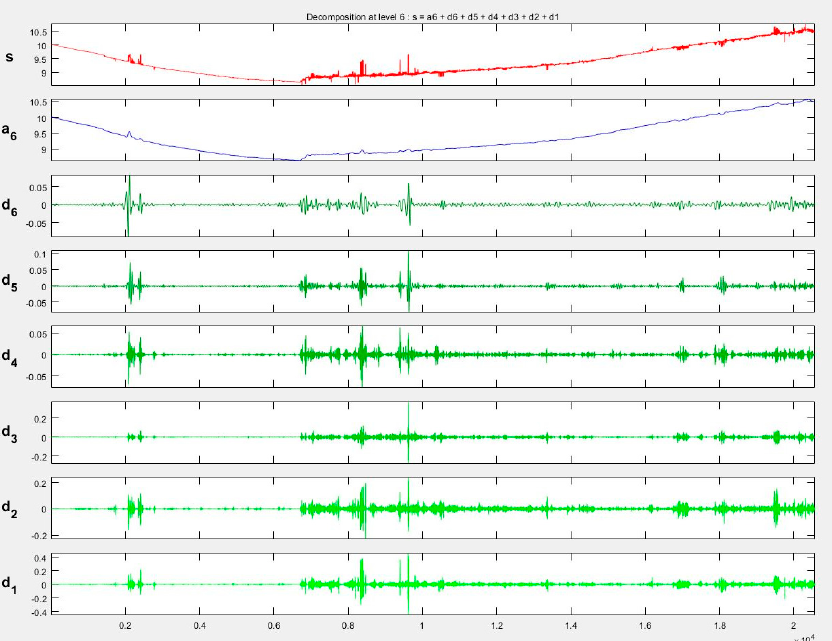
Figure 12. The fragment of decomposition of the Z coordinate with the DB6 L6 wavelet, s—original signal, a—approximation, d1–d6—decomposition